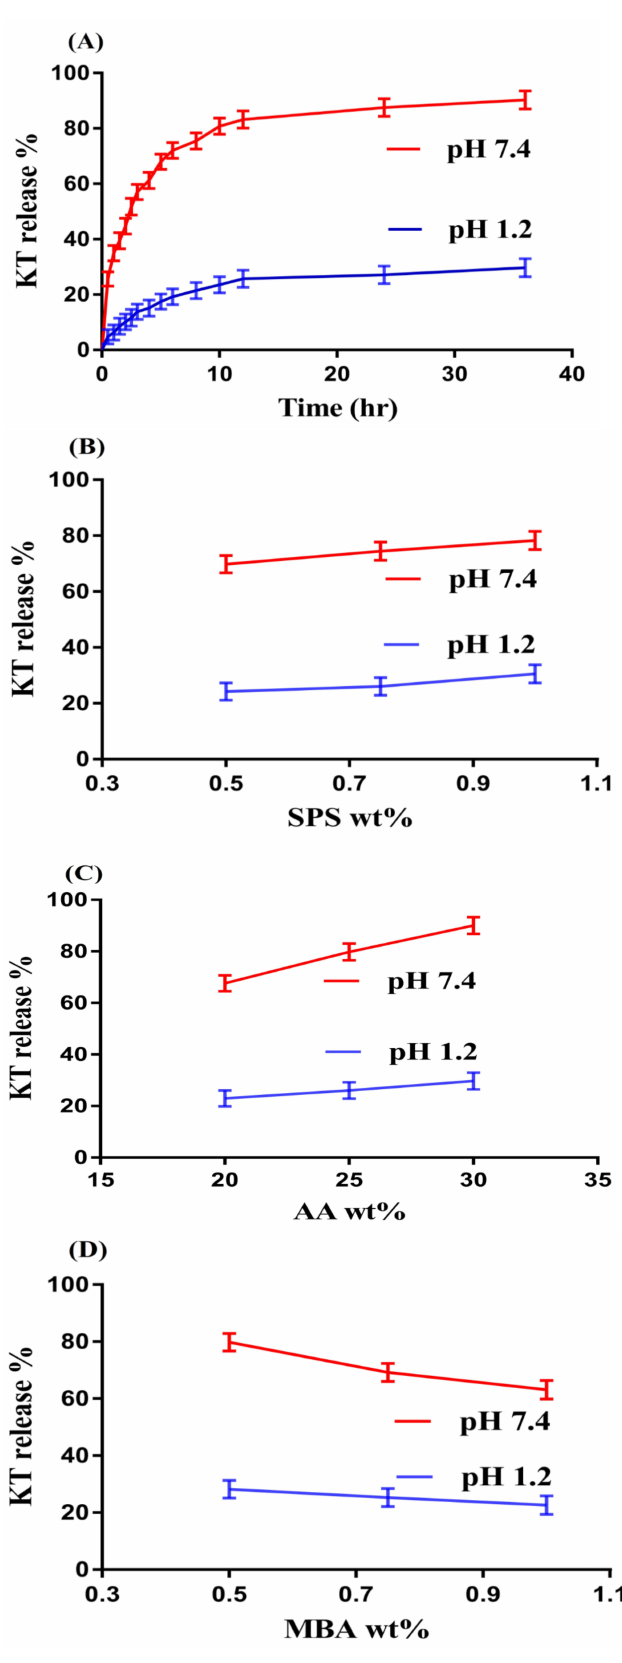
Figure 2. Effects of ( A ) pH, ( B ) SPS, ( C ) AA, and ( D ) N (cid:48) , N (cid:48) -Methylene bisacrylamide MBA on ketorolac tromethamine (KT) percent release from SPSPAA